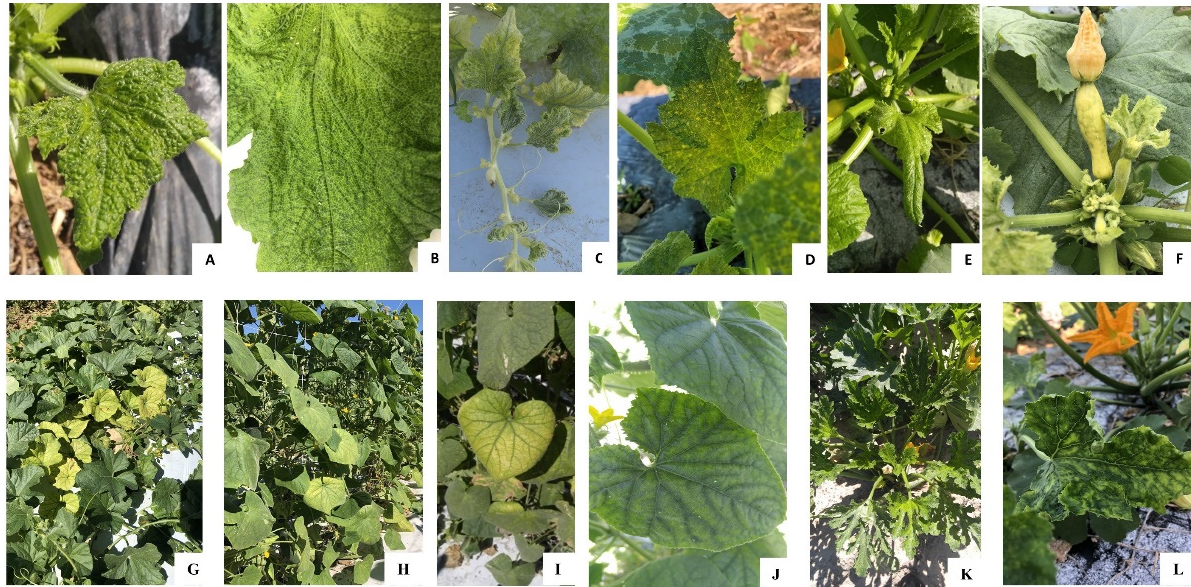
Figure 1. The different types of symptoms observed on squash plants included ( A ) chlorosis and crinkling, ( B ) vein yellowing, ( C ) interveinal leaf chlorosis, ( D ) yellow spots, and ( E ) severe stunting or bunching of leaves at the top of the plant. ( F ) Fruits, on squash plants, displayed severe bunching, were distorted, and were streaked with green patches. The main symptom observed on cantaloupe and cucumber was ( G ) interveinal leaf chlorosis, more prominent at the ( G – I ) crown region and milder on the ( J ) younger leaves. Foliage symptoms on zucchini including ( K ) crinkled leaves and a ( K – L ) yellow mosaic pattern.